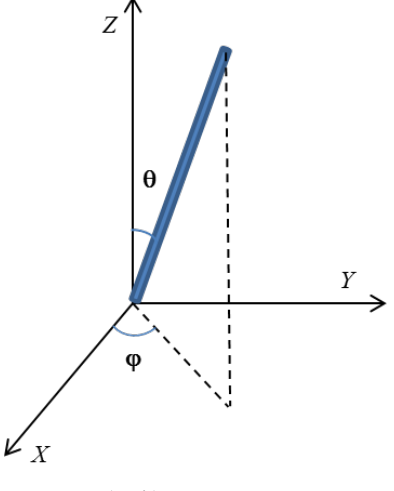
Figure 9. The fiber